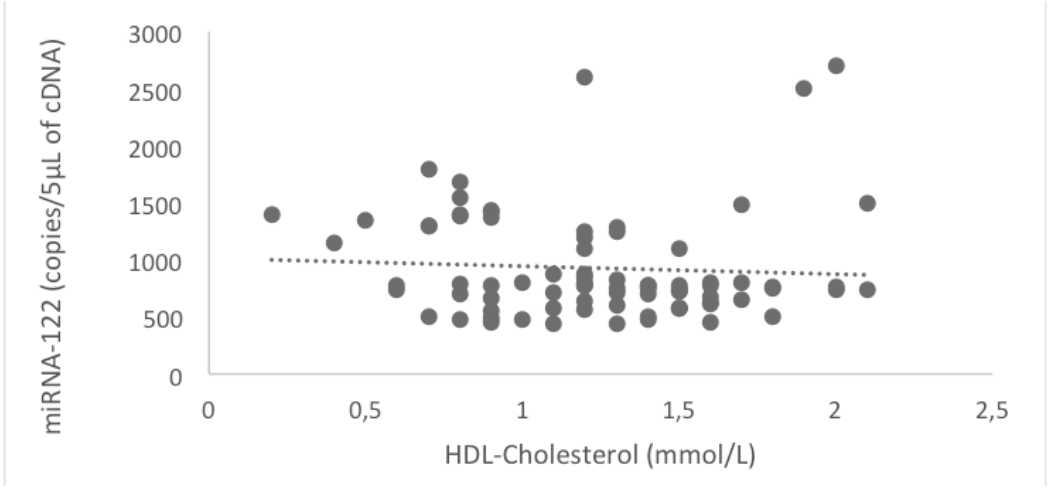
Supplementary Figure 2: Correlation Graph of miRNA-122 with HDL-Cholesterol The correlation between miRNA-122 and HDL-cholesterol was negative, weak and not significant, r = -0.1, p = 0.60, n =